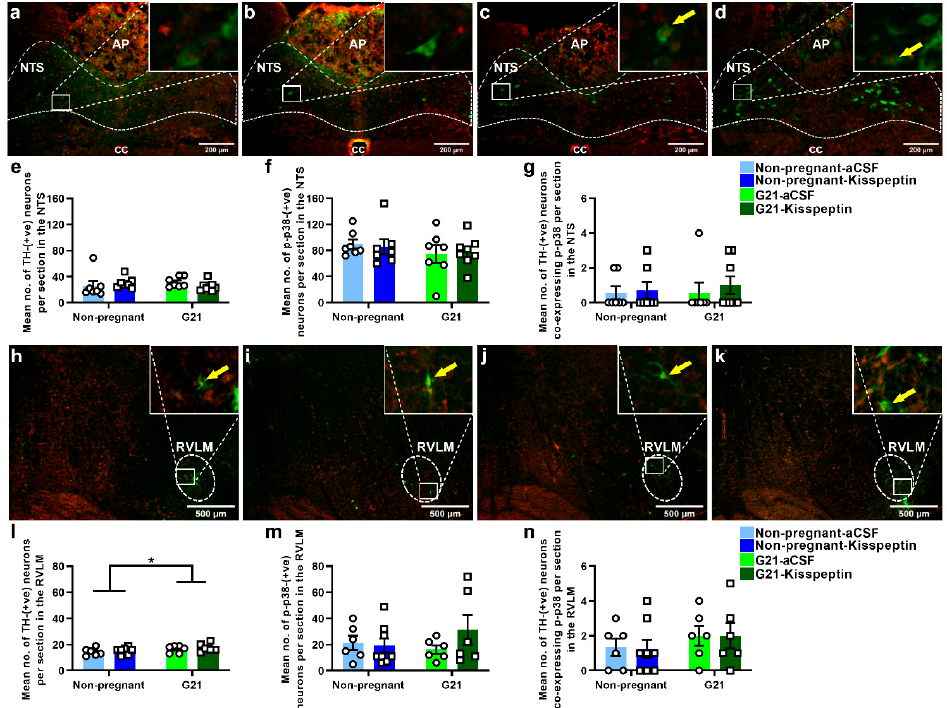
Figure 6. Kisspeptin does not affect p-p38 expression in NTS or RVLM noradrenergic neurons of non-pregnant and G21 rats. Photomicrographs of coronal NTS ( a – d ) and RVLM ( h – k ) sections, within the white dotted area, showing TH-positive neurons (green) and p-p38-positive neu- rons (red) in non-pregnant rats ( a , b , h , i ) and G21 rats ( c , d , j , k ) after ICV administration of